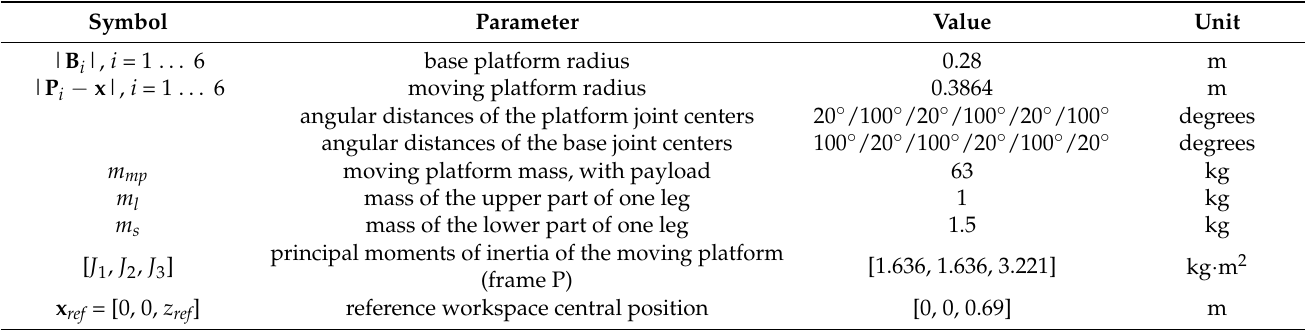
Table 1. Geometrical and inertial parameters of the 3-PUU parallel robot.